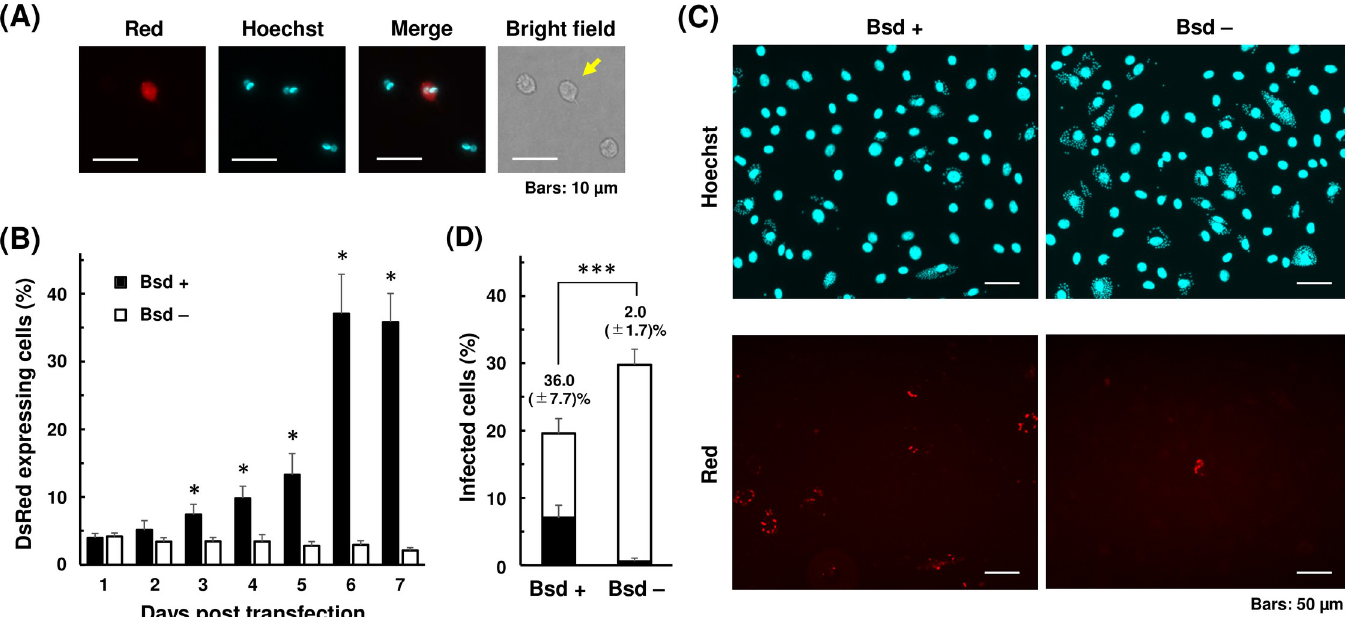
Fig 4. Expression of mDsRed and blasticidin selection in axenic amastigotes. (A) Axenic amastigotes were transfected with 20 μ g of pTREX-mDsRed-Bsd plasmid using X-14 program of Amaxa Nucleofector, and maintained in LIT (10% FBS) at 37˚C. Expression of mDsRed was visualized under fluorescence microscope 1 day after electroporation. An arrow indicates transgenic amastigote. Scale bars: 10 μ m. (B) Blasticidin S was added 1 day after electroporation to select for the positive transfectants. Number of amastigotes was counted every day for the next 6 days. Electroporation and the following selection were performed in triplicates. Mean percentages ( ± SD) of mDsRed-expressing amastigotes in blasticidin added (Bsd +) and not added (Bsd -) cultures are plotted ( � p < 0.05, Mann-Whitney U test). Three independent experiments were performed to ensure reproducibility, and the result of one representative experiment is shown. (C) Cultivated axenic amastigotes in LIT medium with (+) and without (–) blasticidin on day 6 in (B) were used to infect 3T3 cells. Representative images from 4 days post infection are shown. Scale bars: 50 μ m. (D) Percentage of infected 3T3 cells containing mDsRed-expressing (black bar) and not expressing (white bar) amastigotes. Host cell containing � 3 amastigotes was defined as infected. Values represent the average ( ± SD) of at least six countings from duplicated experiments, using microscopy images captured at different locations of culture wells ( ��� p < 0.001, Mann-Whitney U test).